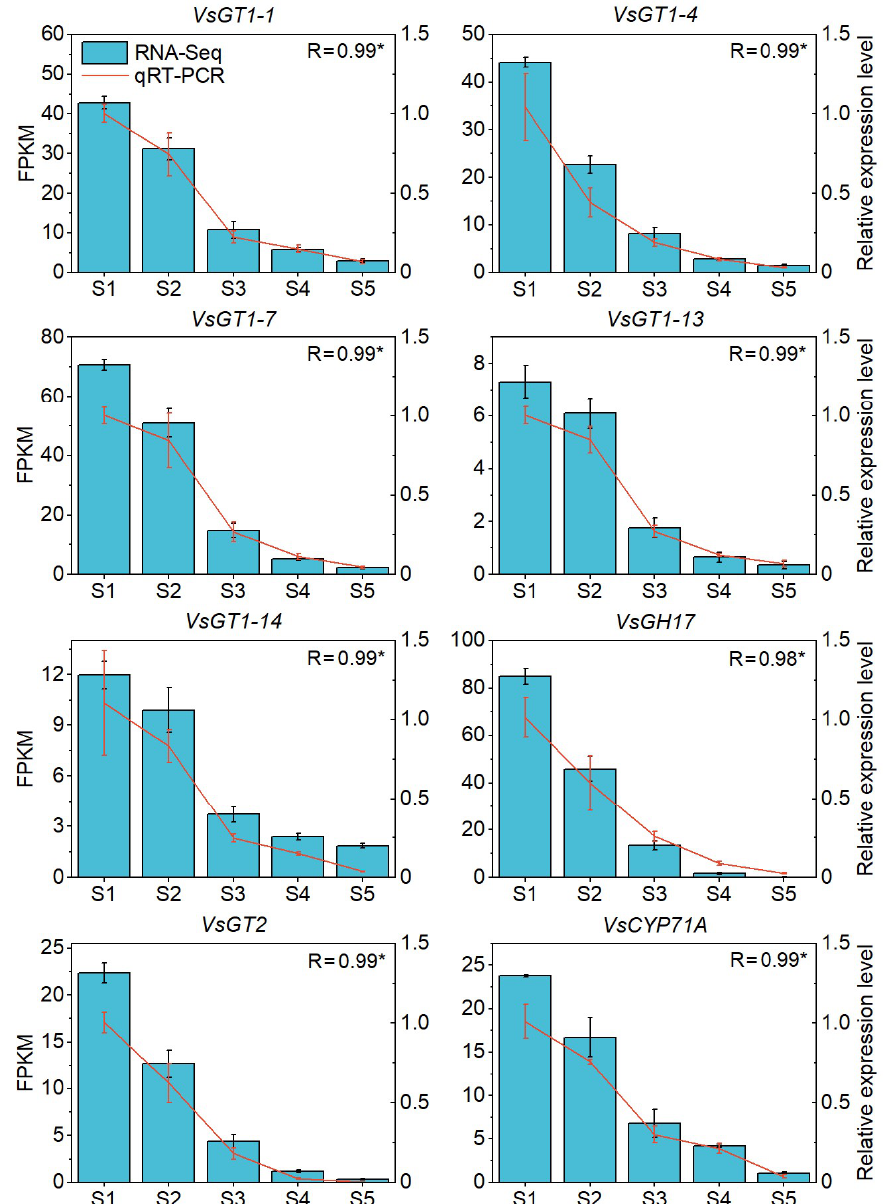
Figure 6. The qRT-PCT confirmation of eight of the key regulatory genes in HCN synthesis. The Y-axis on the left side of each chart indicates the expression level (FPKM) of RNA-seq. The Y-axis on the right side of each chart indicates the relative expression of qRT–PCR, * p < 0.05. During hydrocyanic acid synthesis, the transformation of amino acids to aldoxime is catalyzed by the P450 enzyme CYP79 , and another P450 enzyme CYP71A is responsible for the subsequent conversion of aldoxime to hydroxynitrile. Hydroxynitrile is then gly- cosylated and stabilized by UDP-glycosyltransferase (UGT85B1), resulting in the for- mation of vicianin. When herbivores or pathogens damage plant tissues, β-Glucosidase in the tissue meets and degrades vicianin, followed by α-Hydroxynitrile lyase, which de- grades intracellular vicianin, generating and releasing toxic HCN, as well as aldehyde, i.e., a chemical defense reaction (Figure 7). The expression trends of genes related to HCN